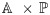
Transition probabilities in the superior metaplastic models and a superior family of metaplastic models with only one parameter.(a-c) Plotted are the transition probabilities for superior models with different numbers of meta-states (N = 4, 6, 8) for a given value of average precision. Only a few transition probabilities are non-zero, and the rest vary together, revealing the specific structure of metaplasticity that is useful for overcoming the APT. Finding optimal transition probabilities is more difficult for models with larger numbers of meta-states because the performance of those models are more robust against fluctuations in the model parameters. (d) The structure of the special family of metaplastic models with only one parameter (for N = 4,6,8 meta-states). (e) Adaptability as a function of the precision for the simple metaplastic models using the mean-field approach. (f) A  × ℙ as a function of the precision using the mean-field approach.